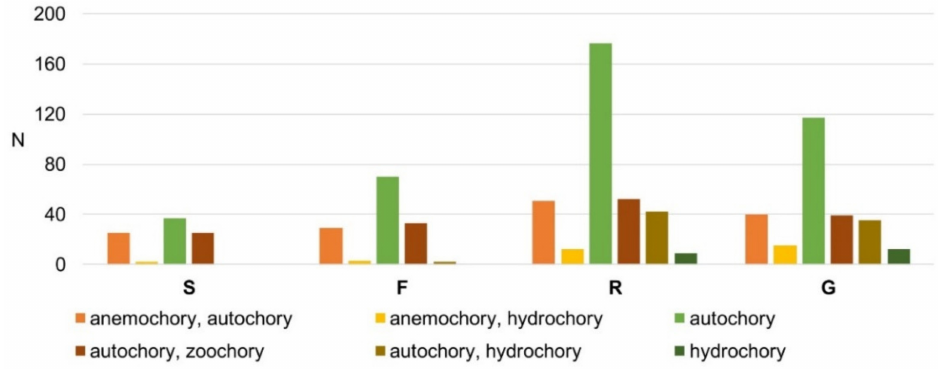
Figure 8. Number of species with different dispersal strategy (S—open swimming pools, F—multi-media fountain, R— reservoir, G—gravel pit